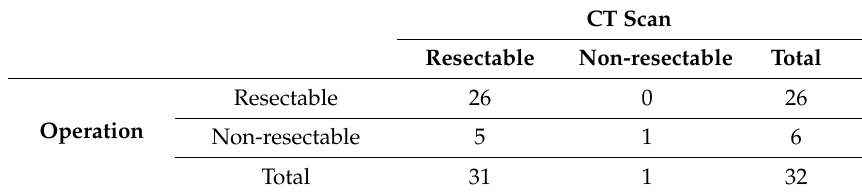
Table 2. The correlation between the preoperative CT scan findings and exploratory operation.